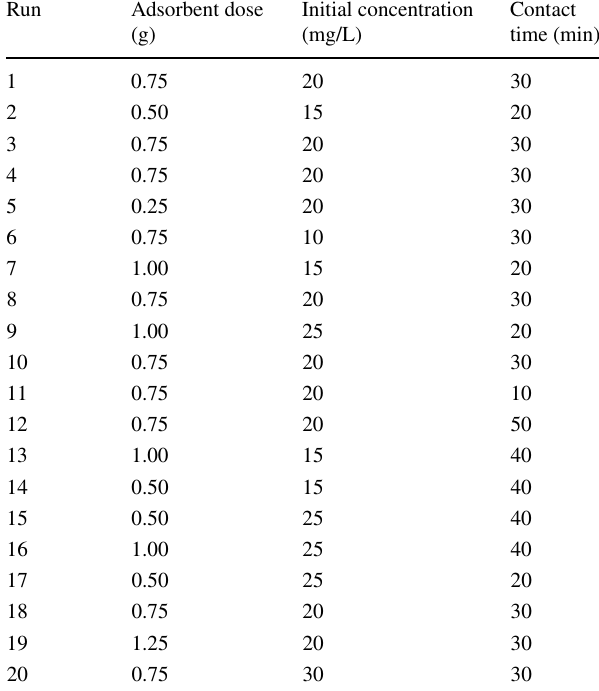
Table 2 Experimental runs generated by CCD in RSM